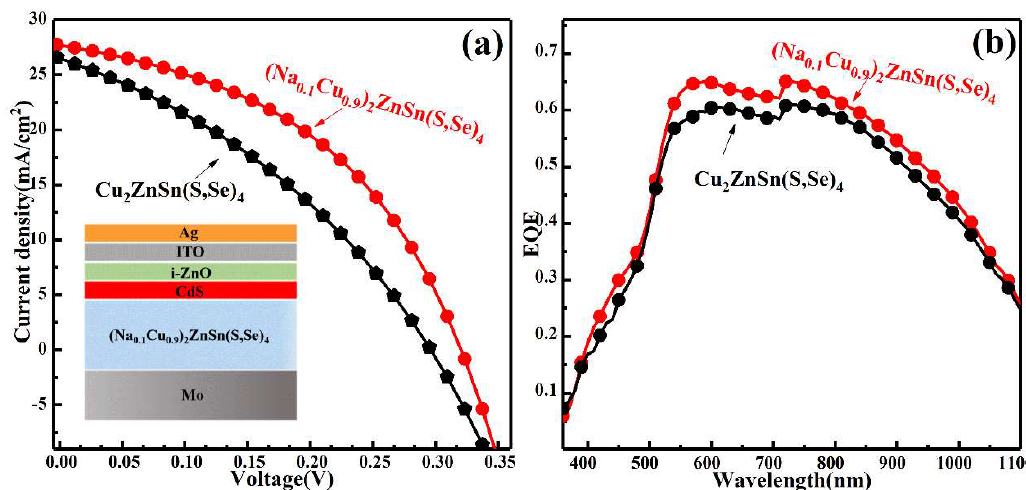
Figure 7. ( a ) J–V characteristics and ( b ) EQE of Cu 2 ZnSn(S,Se) 4 and Na-doped Cu 2 ZnSn(S,Se) 4 solar cells.